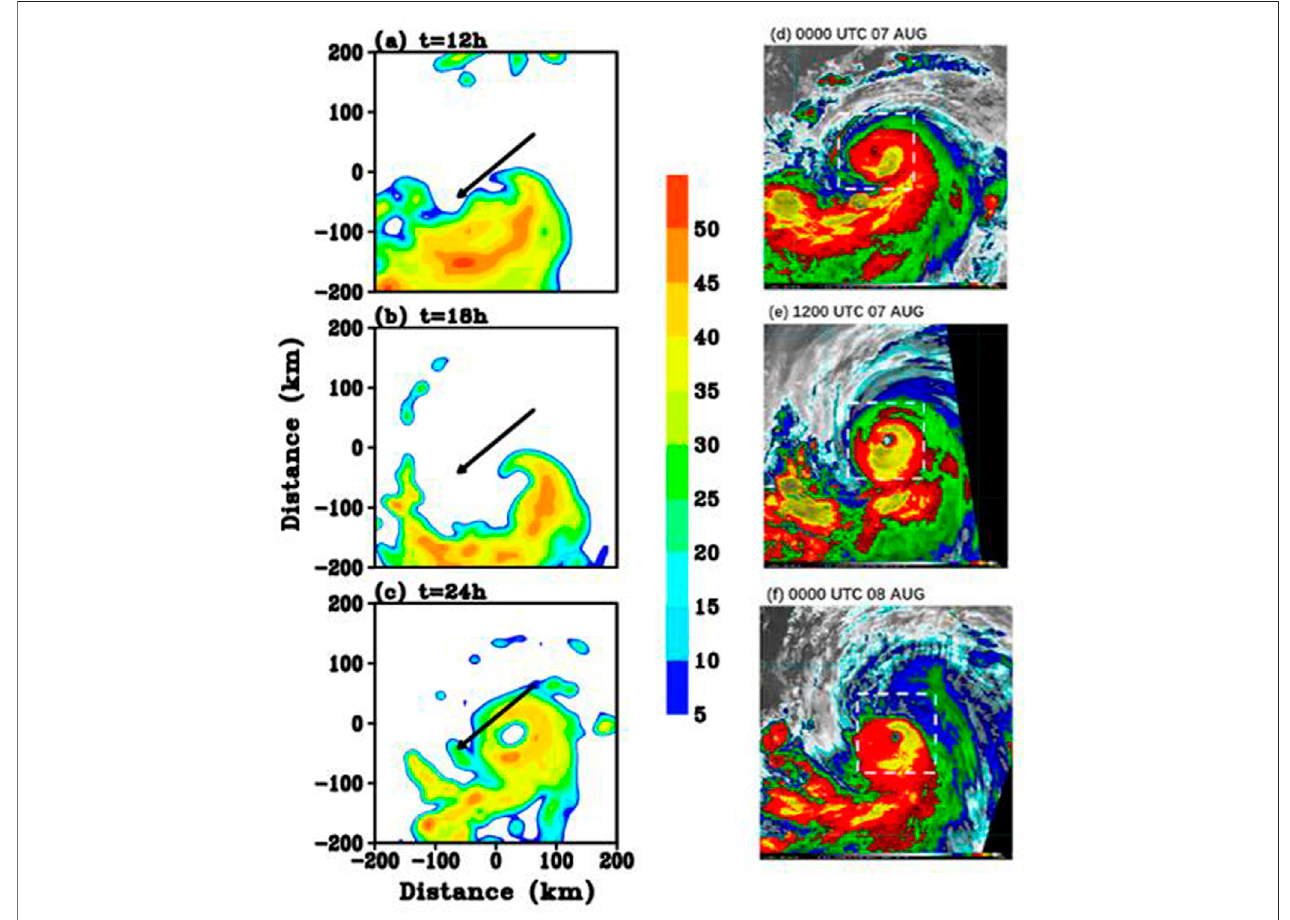
FIGURE2| Leftpanels:snapshotat12,18,and24 hoftheradarre fl ectivityat5-kmheight(shaded;units:dBZ)andtheVWSbetween15and2 km(blackvectors; units: m s − 1 ) at 17 km starting on 0000 UTC 6 August. Right panels: the time evolution of the satellite-observed infrared brightness temperatures from 0000 UTC 7 Augustto0000UTC8AugustontheNOAAwebsite.Thewhitedashedboxintherightpanelsisthe200×200 kmareacenteredbytheTC,coveringthesameareaasin the left panels.